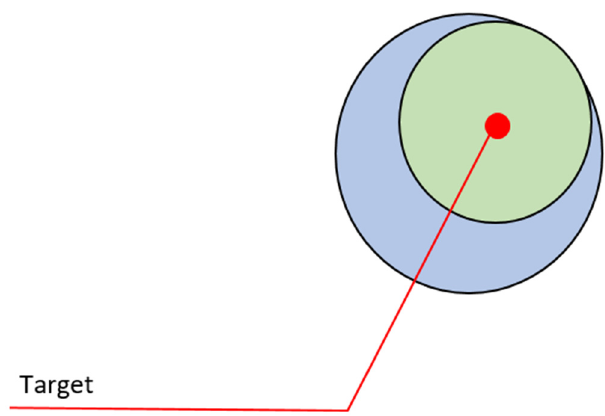
Figure 8. Defining the same coordinate to different robots.